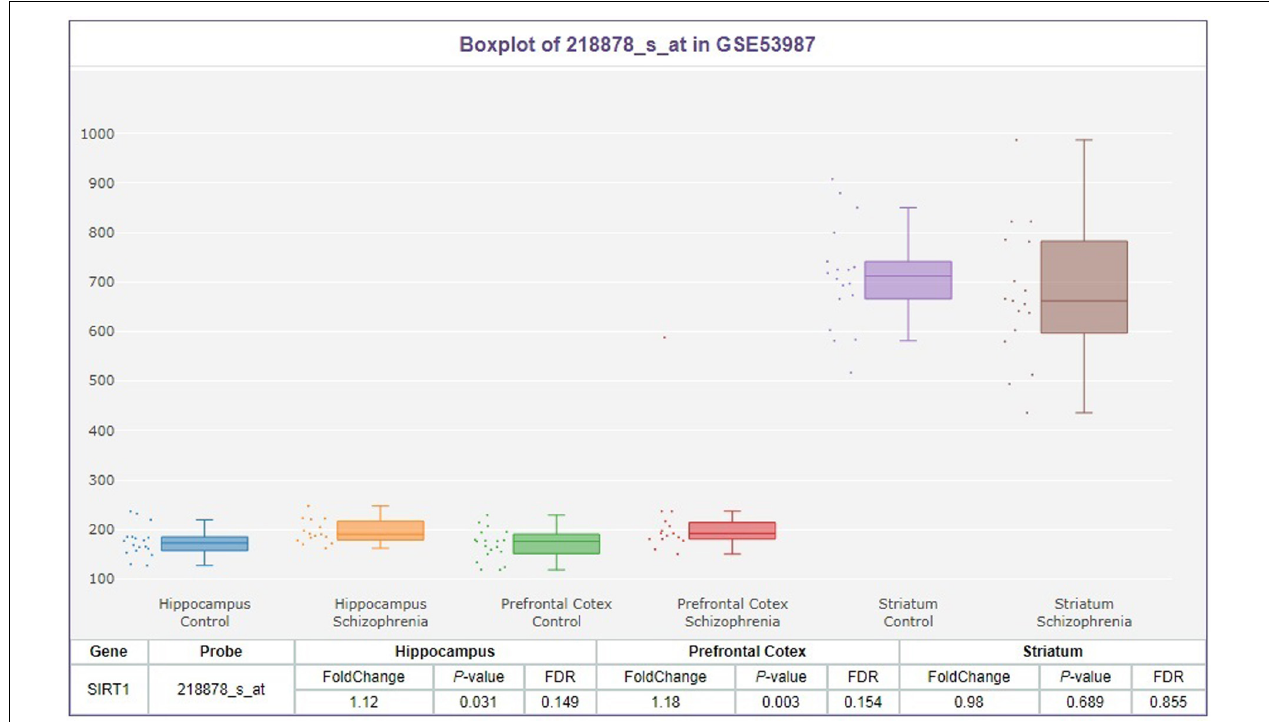
FIGURE 1 | Differential expression of SIRT1 mRNA in brain between patients with schizophrenia and healthy controls. Each bar represents the average level of SIRT1 mRNA expression. Error bars represent the standard deviation of the mean value. Data was extracted from the SZDB database (http://www.szdb.org/).